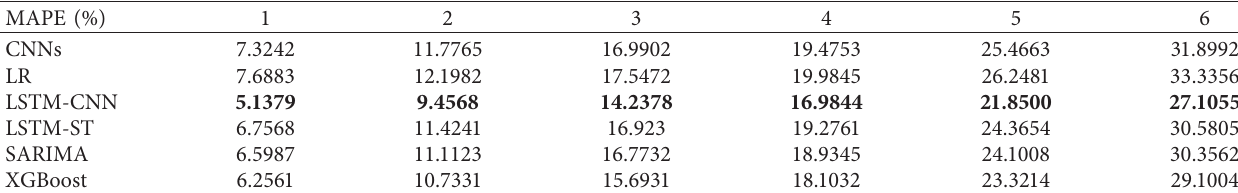
Table 5: MAPE comparison of multistep